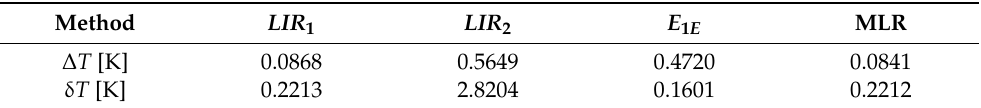
Table 2. The accuracy (Δ T ) and precision (δ T ) of single-parametric ( LIR 1 , LIR 2 , and E 1E ) and mul- tiparametric temperature readings from the near-infrared emission of Ca 6 BaP 4 O 17 :Mn 5+ (0.75 at% Mn) averaged over the complete temperature range.